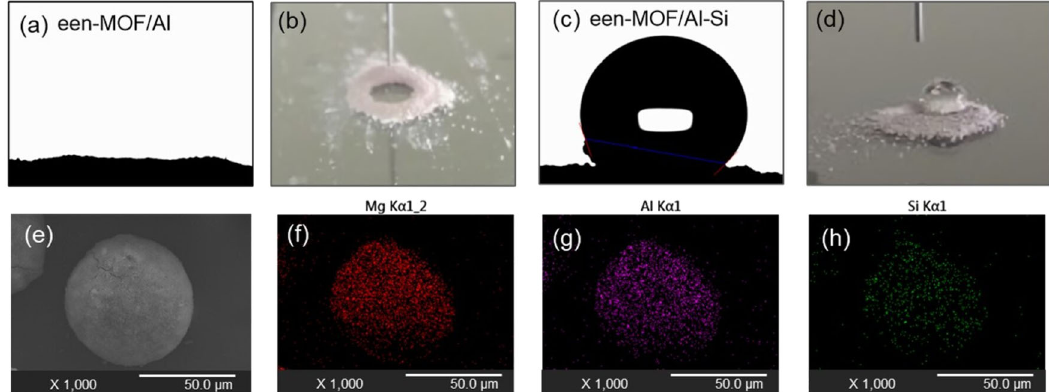
Fig. 3 Characterizations of een – MOF/Al – Si. a Contact angle of een – MOF/Al. b Photograph of een – MOF/Al after dropping water. c Contact angle of een – MOF/Al – Si. d Photograph of een – MOF/Al – Si after dropping water. e SEM image of een – MOF/Al – Si. f – h SEM-EDS mappings of een – MOF/Al –